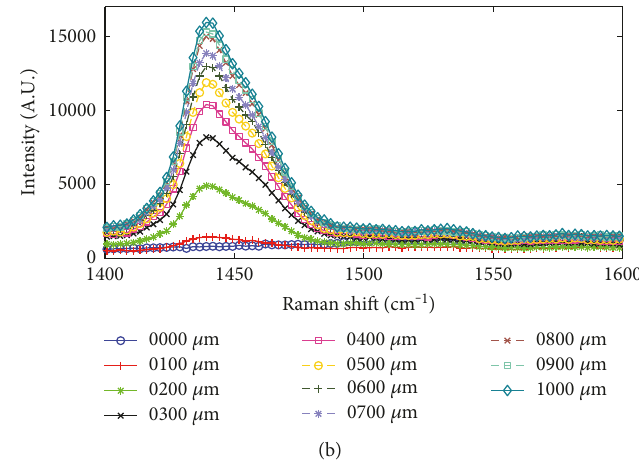
Figure 5: Decay of silicon wafer ’ s characteristic peak and increase of intralipid ’ s one characteristic peak while the distance between the silicon wafer and the probe end tip increases in the phantom measurement as shown in Figure 3. The laser power was fi xed to 28.7mW. Notice that from full contact to 100 μ m separation, the Raman characteristic peak of the silicon increases and it might happen in the combination of the mismatch of refractive indices between intralipid, silicon wafer, and the probe and the e ff ect of the plano-convex lens in front of the excitation and detection fi bers. Mixture of characteristic peaks of the silicon and intralipid still exists till the distance of 800 μ m, and it implies that when measuring highly scattering medium in near-infrared (NIR) range such as the biological tissues, the working distance of the probe would be longer than the one described in the speci fi cation. Table 1: The tumor volume variation from the four rats in the rat